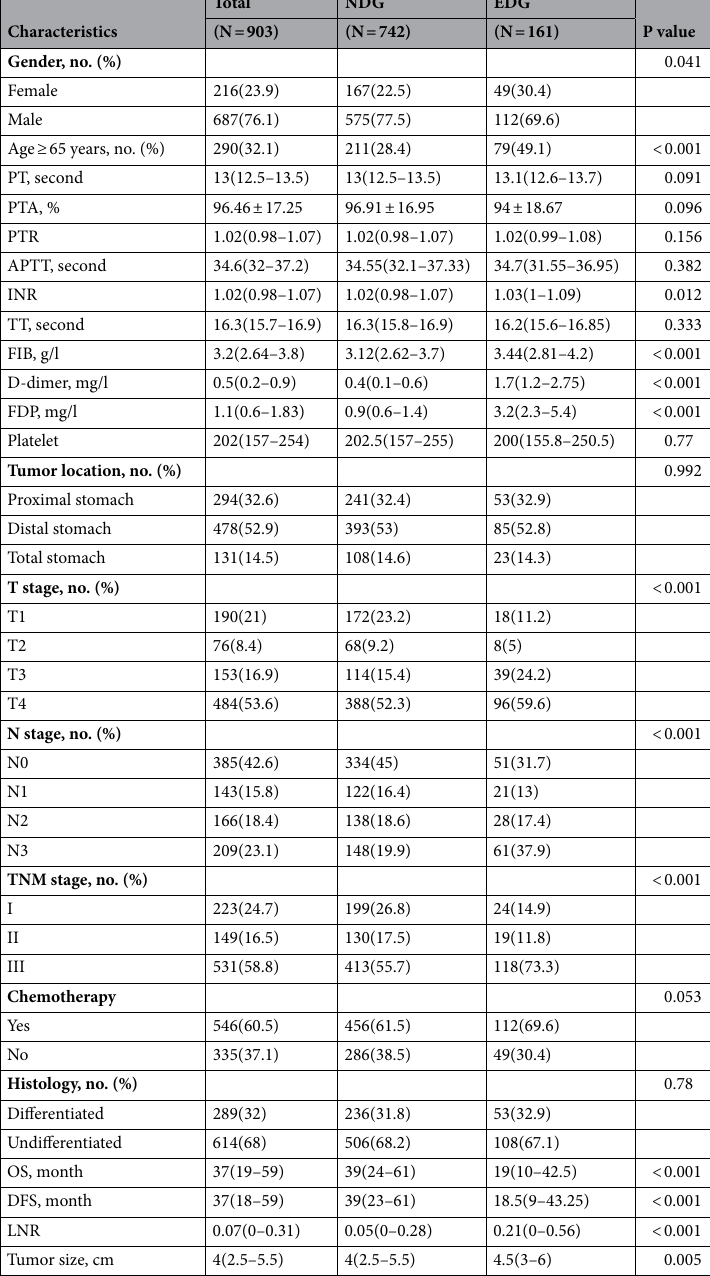
Table 1. Demographic and baseline characteristics of the two patient groups before PSM (N = 903). Abbreviations: PSM, Propensity Score Matching; NDG, normal D-dimer group (< 1 mg/l); EDG,